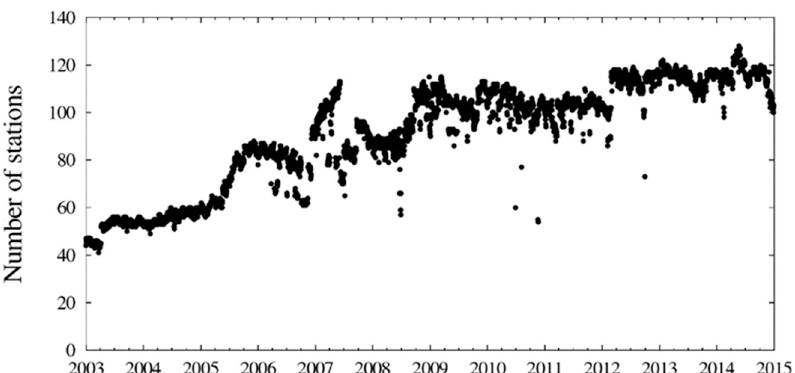
Figure 2. Number of stations delivering high-rate Receiver Independent Exchange Format (RINEX2) data for the period 2003–2015.